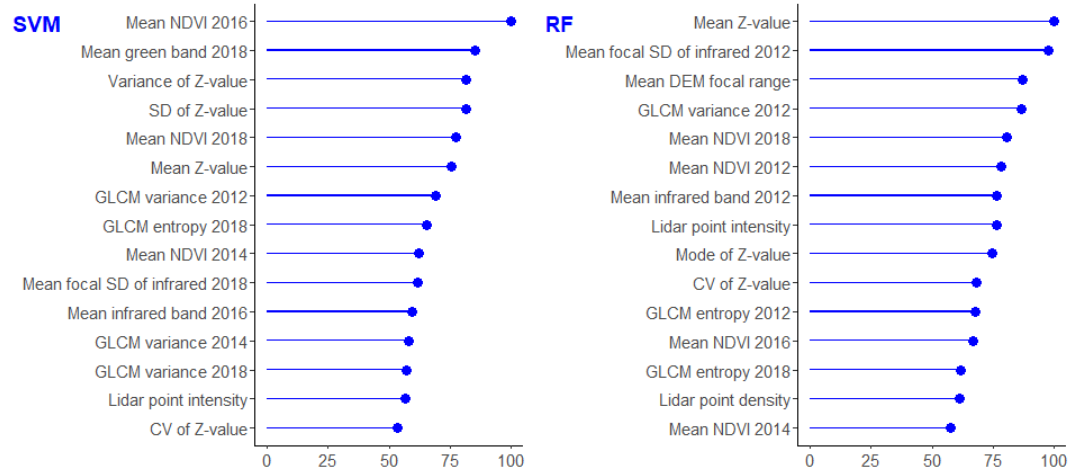
Figure 6. The 15 most important features ranked by support vector machine (SVM) and random forest (RF) over 100 runs for the second-step classification. NDVI, SD, GLCM, and CV are acronyms for normalized difference vegetation index, standard deviation, gray-level co-occurrence matrix, and coefficient of variance, respectively. The values on x -axis indicate the importance of each variable for model construction with higher value suggesting higher importance.